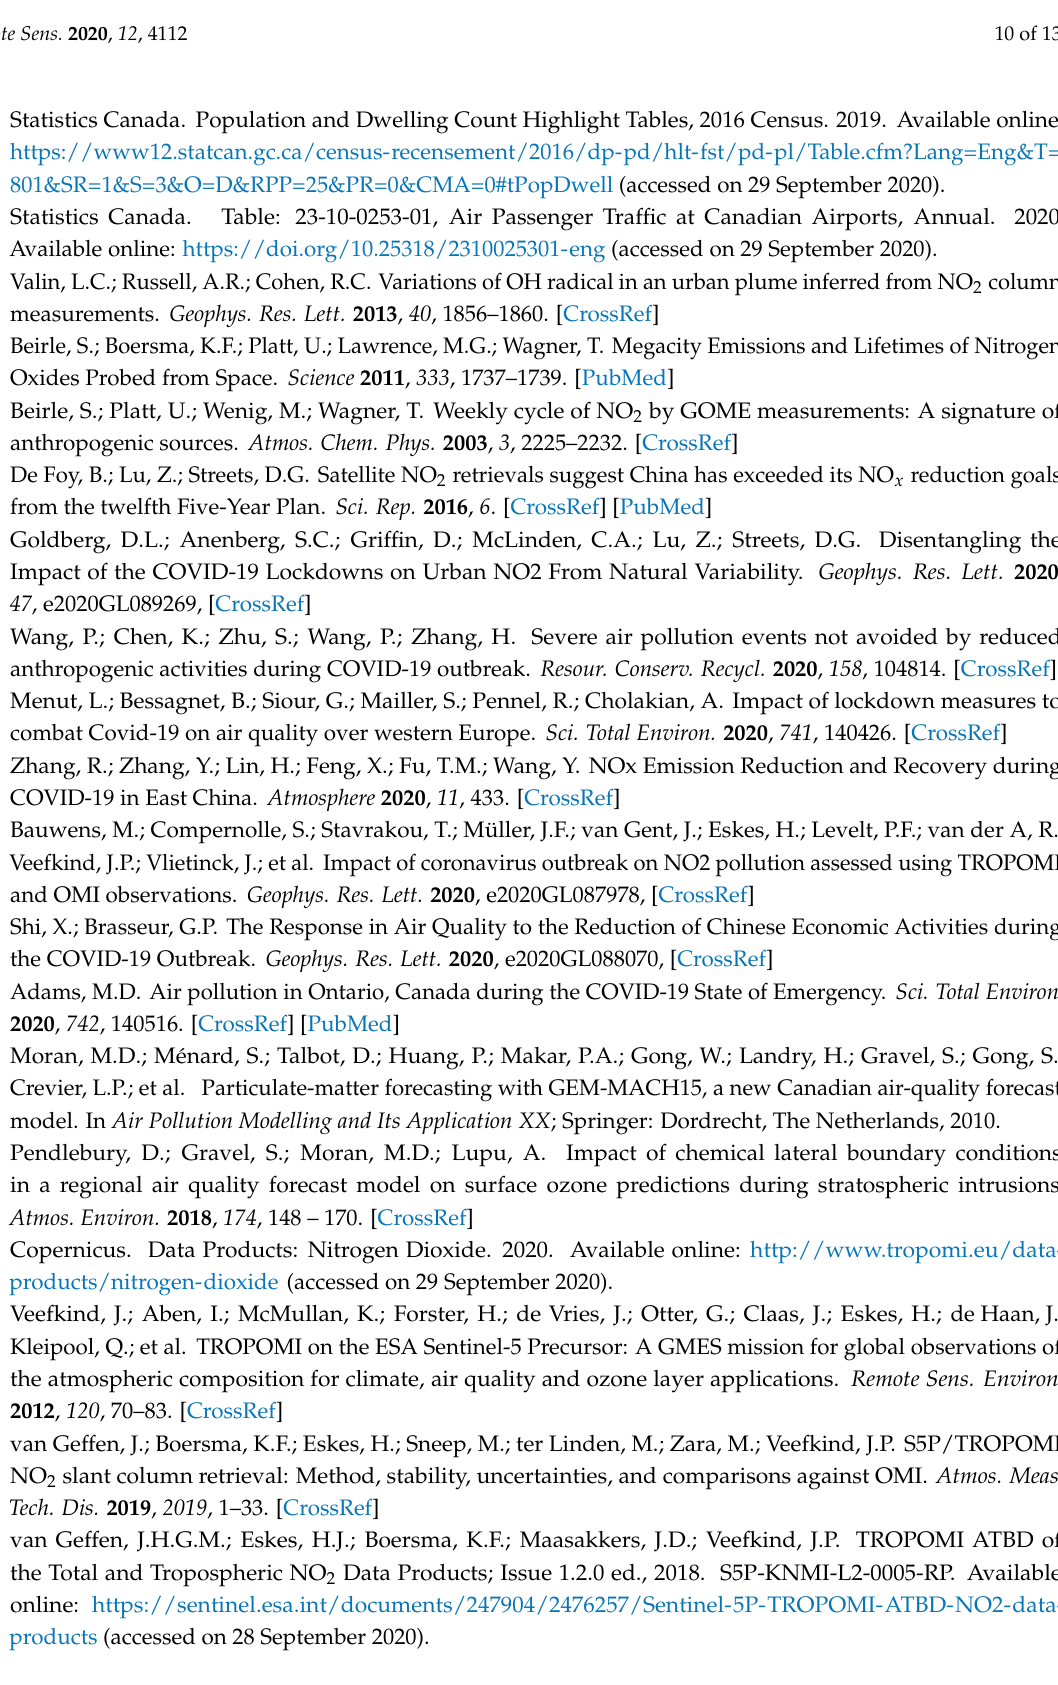
Table: 23-10-0253-01, Air Passenger Traffic at Canadian Airports, Annual.